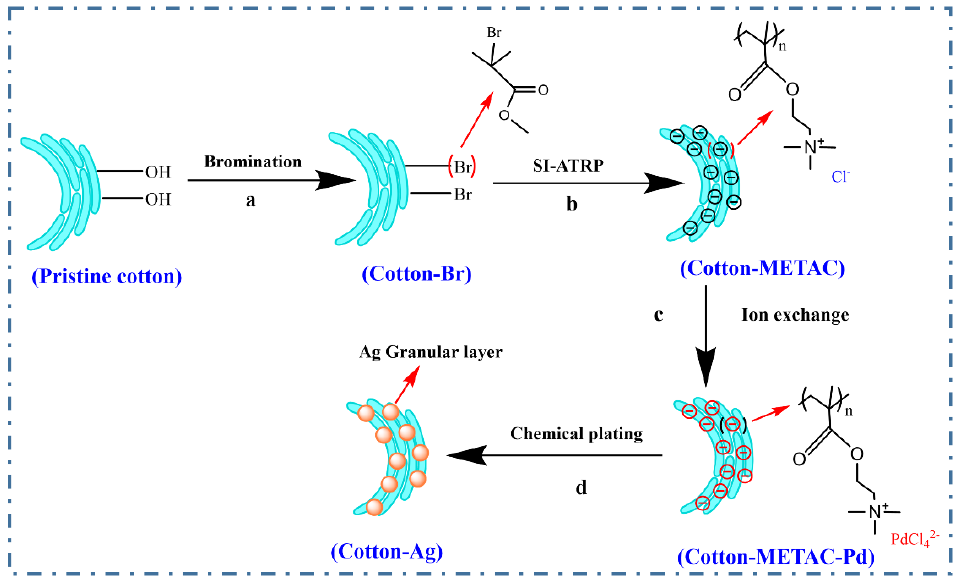
Figure 1. Schematic diagram of the preparation process of ( a ) bromination of pristine cotton, ( b ) methacryloxyethyltrimethyl ammonium chloride modification of Cotton-Br, ( c ) preparation of Cotton-METAC-Pd, and ( d ) Ag-plating of Cotton-METAC-Pd for the preparation of Cotton-Ag.